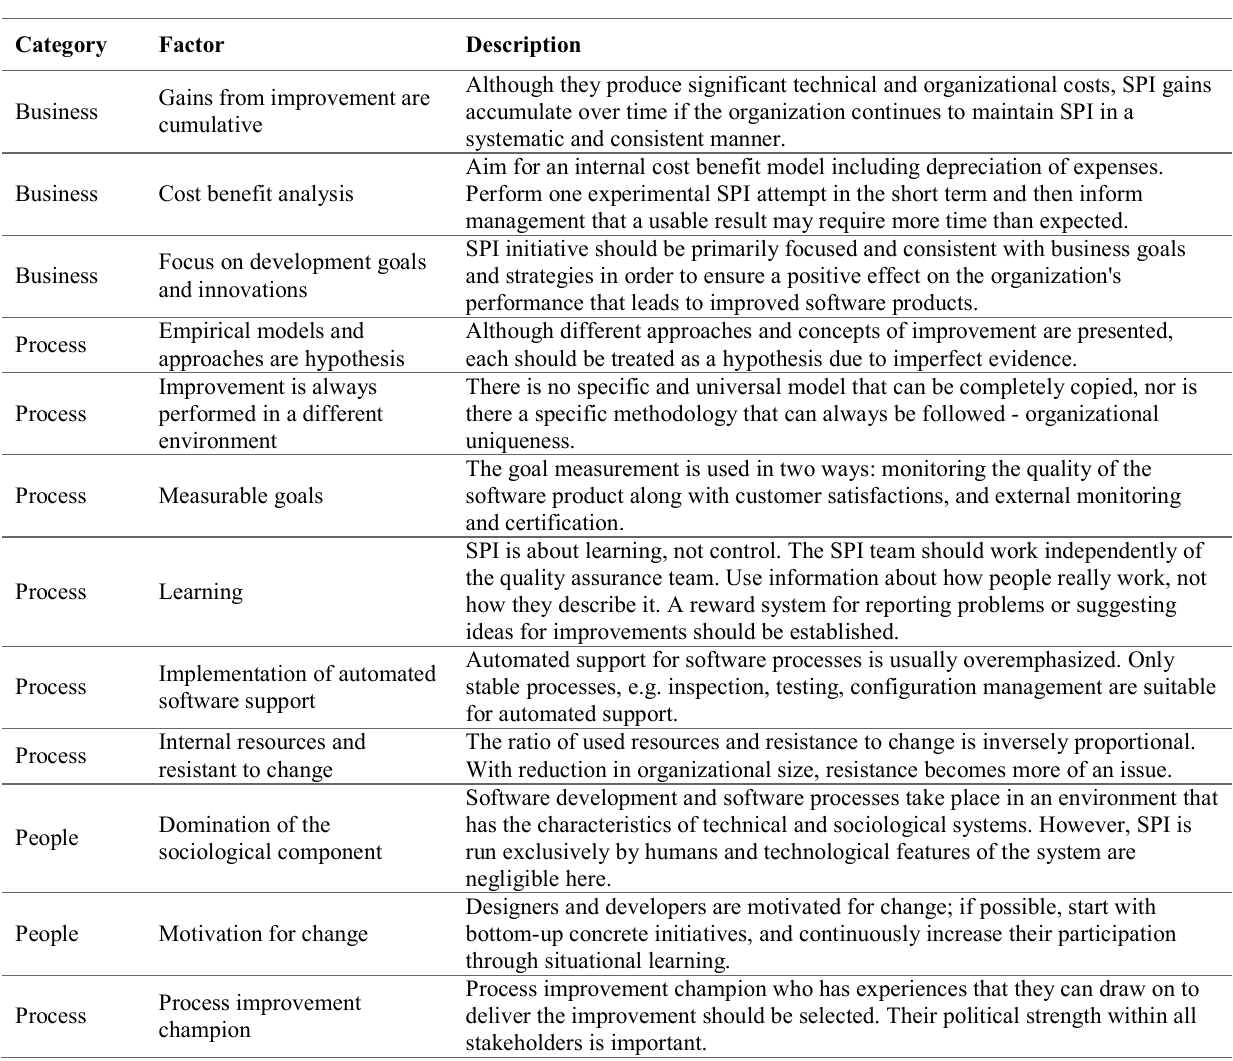
Table 1. SPI success